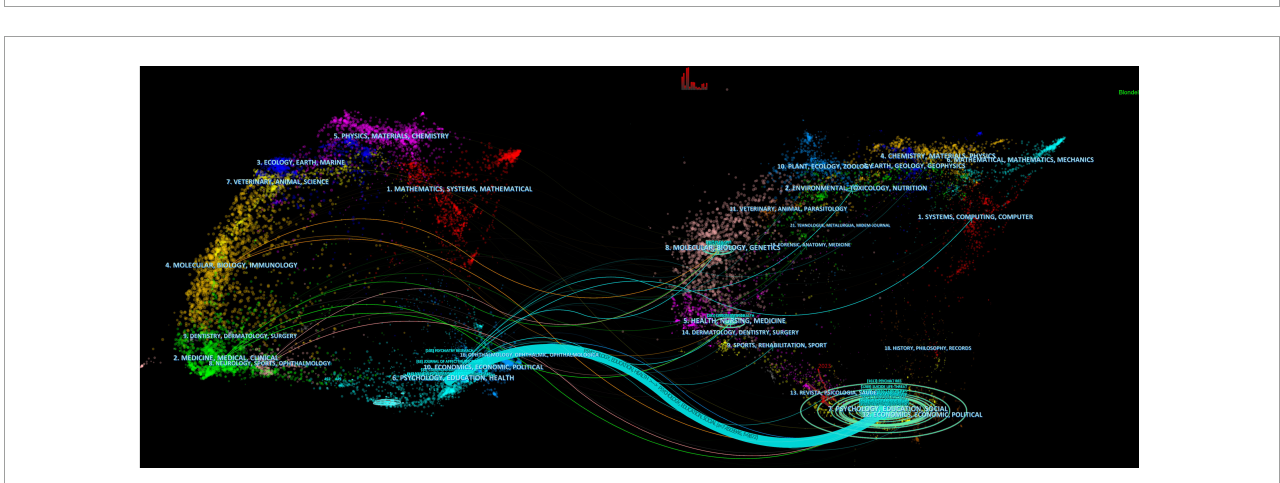
FIGURE7 The dual-map overlay of journals contributed to publications on non-suicidal self-injury (NSSI) by CiteSpace. The left side represents the citing journals and the right side represents the cited journals.